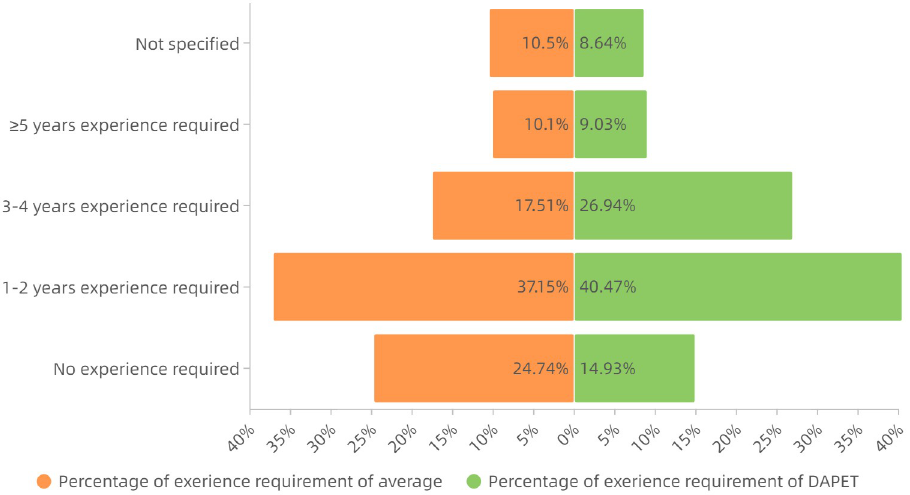
Fig 10. Comparison of distributions of work experience